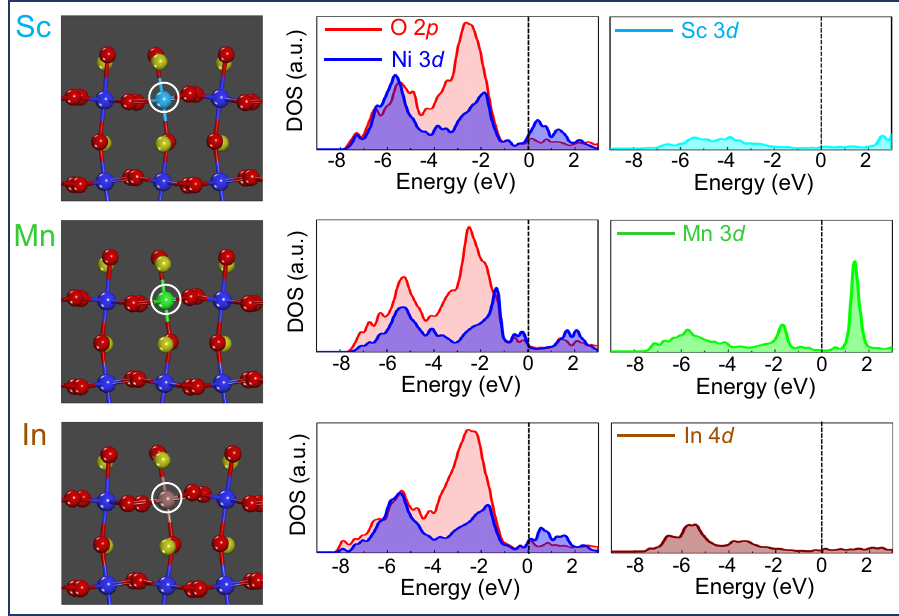
Fig. 2 DOS at the LaNiO 3 (001) cubic surface with various dopants (2). The second set of DOS plots for O 2 p , Ni 3 d , and metal 3 d states is provided for each case. In contrast to the fi rst set for Fe, Co, Cr, and Al doping, the dopants, Sc, Mn, and In, have neither a substantial in fl uence on the total DOS nor induce any Ni 3 d -state variation near the Fermi